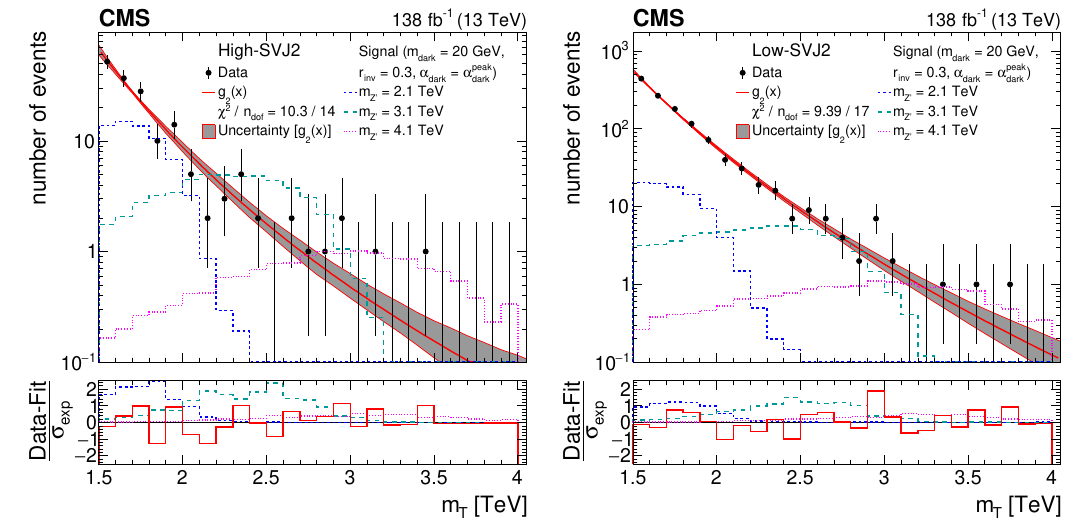
distribution for the high-SVJ2 (left) and low-SVJ2 (right) signal regions, Figure 6 . The m T comparing the observed data to the background prediction from the analytic fit ( g √ x = m / s ). The lower panel shows the difference between the observation and the prediction T divided by the statistical uncertainty in the observation ( σ example signal models, with cross sections corresponding to the observed limits, are